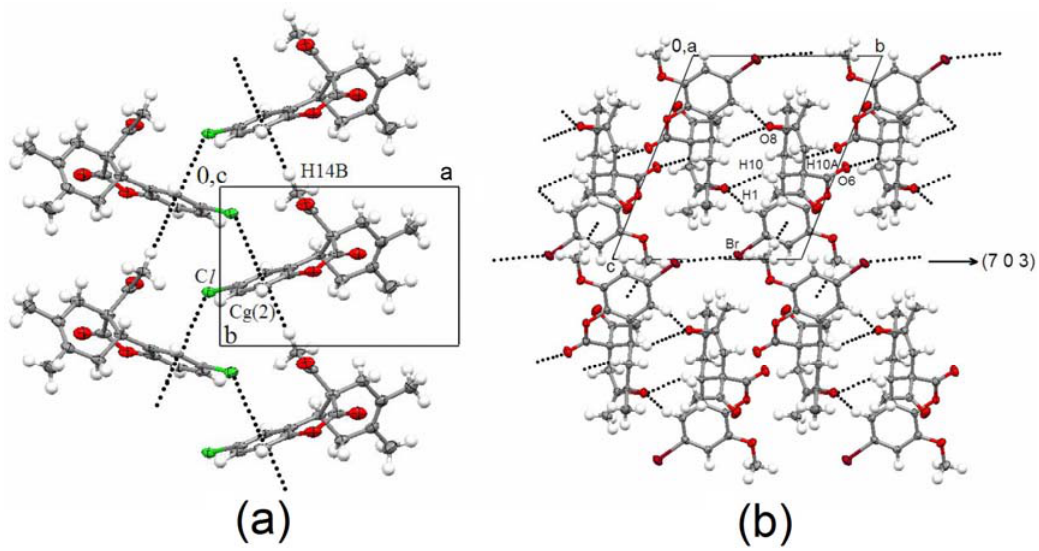
Figure 3. Supramolecular structure of compound 15i . (a) View in the bc plane showing CH···O and Br···Br contacts. (b) View of bifacial CH···  contacts developing the third dimension along the (7 0 3) direction. Dashed lines represents intermolecular CH···A (A = O,  )